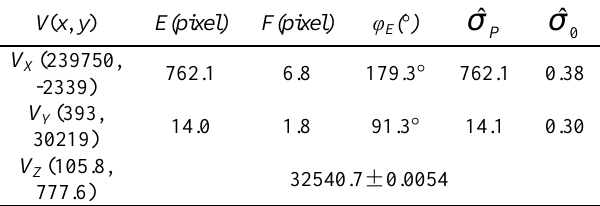
Table 2. The error ellipse parameters of V X and V Y for Figure